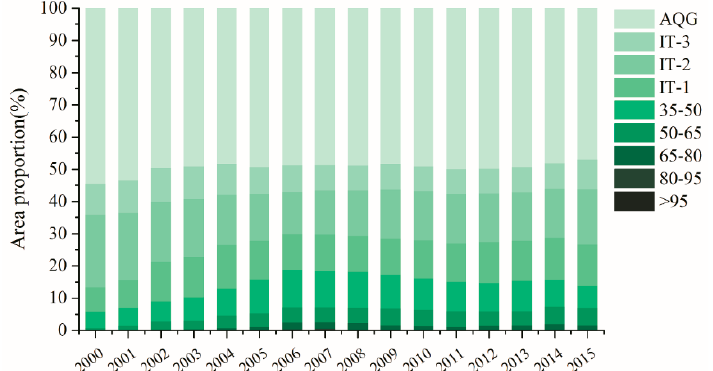
Figure 7. Area proportion of China under different PM 2.5 concentration intervals from 2000 to 2015.